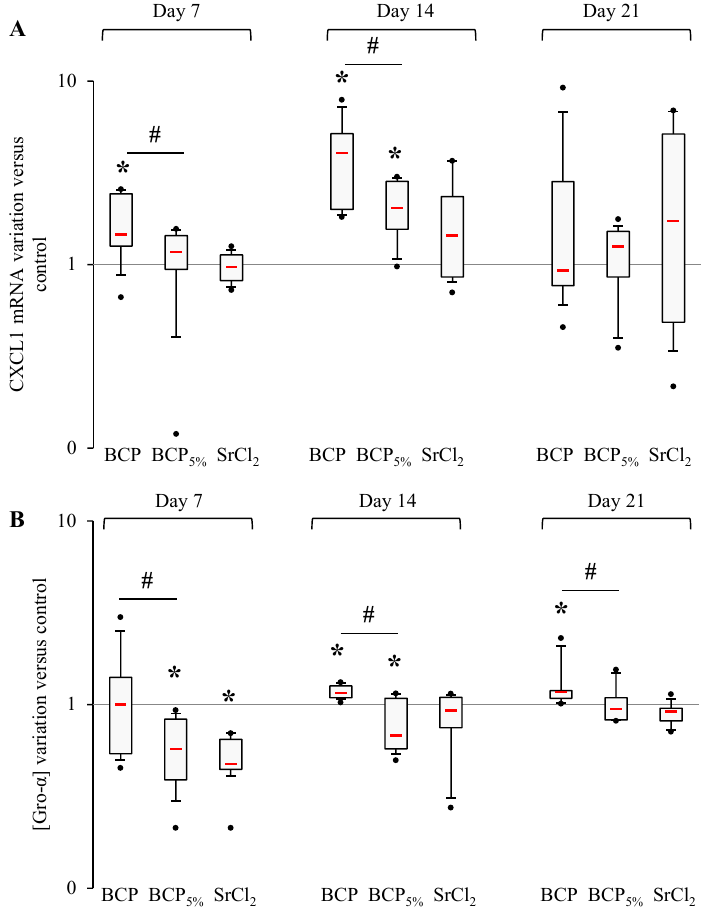
Figure 3. Strontium effect on Gro- α production by human primary bone cells. ( A ) CXCL1 and mRNA production were evaluated by RT-PCR analysis performed (as described in the Materials and Methods section) after 7, 14, and 21 days of stimulation by BCP, BCP 5% , and SrCl 2 . Experiments were performed on 5 independent donors in duplicate. Data are shown as specific variation of target genes mRNA using the 2 −ΔΔ Ct method (HPRT1 was used as internal control); ( B ) Gro- α concentration was measured in cell supernatants after 7, 14, and 21 days of stimulation by BCP, BCP 5% , and SrCl 2 . * means p < 0.05 when compared with control and # p < 0.05 when compared with BCP. Red bars represent median values. Black points represent maximum and minimum values. Black bars represent first and ninth deciles and the limits of white rectangle represents first and third quartiles.